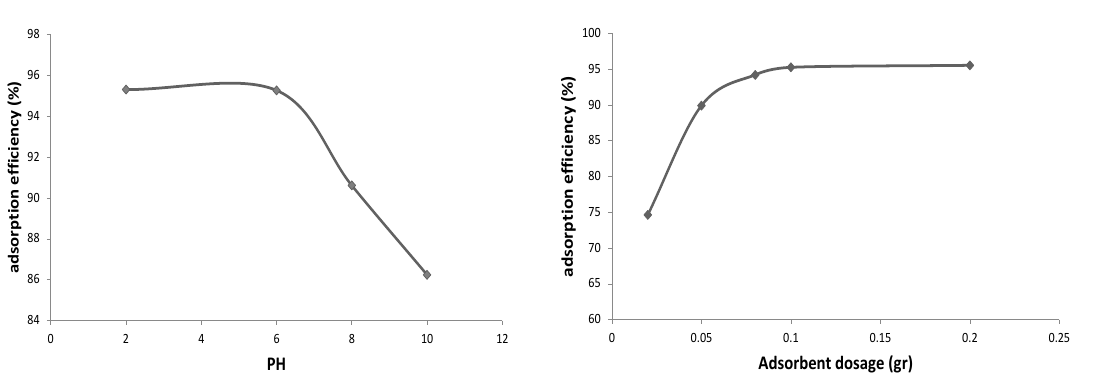
Fig. 3. Effect of pH on adsorption efficiency of Amido Black 10B dye onto Polyaniline nano-adsorbent Fig. 4. Effect of adsorbent dosage on adsorption efficiency of Amido Black 10B dye onto